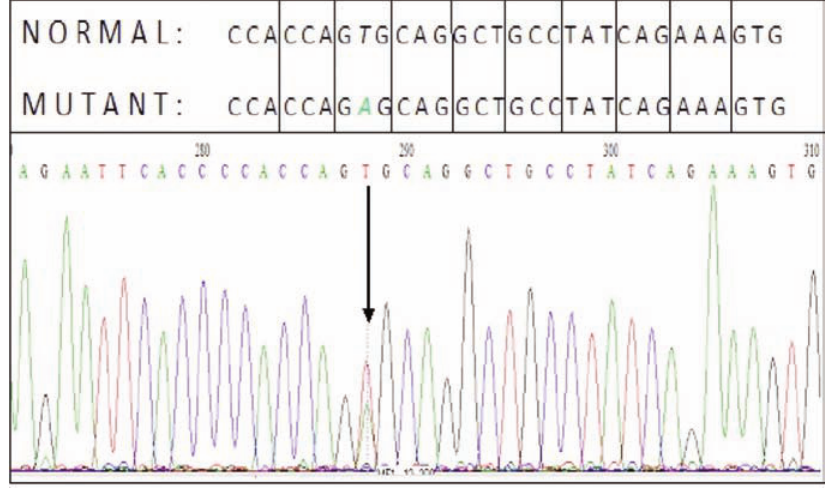
Figure 3. Hemoglobin Hofu